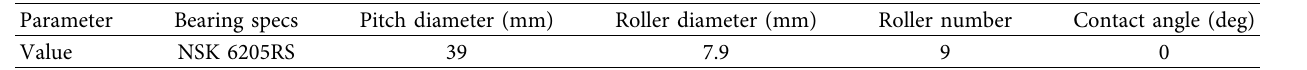
Table 3: Experimental bearing parameters in case